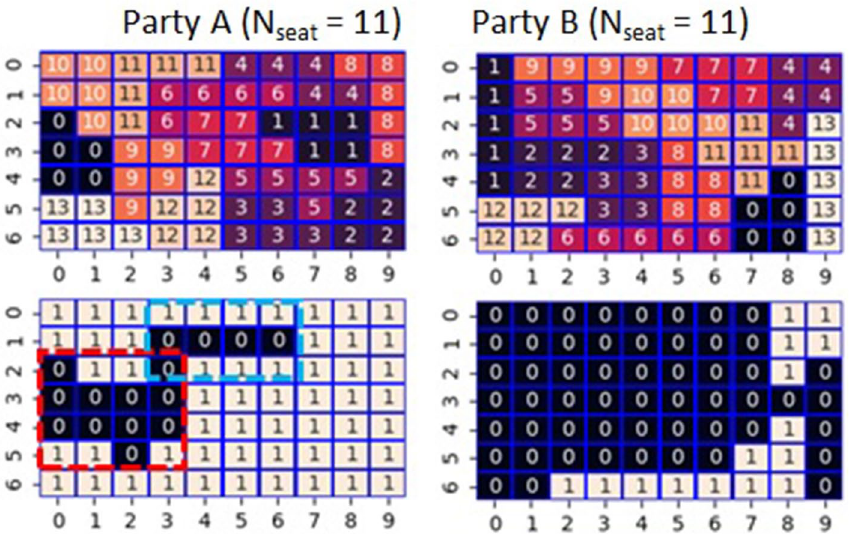
Figure 2. Calculated result of maximizing the number of seats so that party A or B has an advantage with imposing the rook constraint concerning the supporter’s distribution shown in Fig. 1 (Case 1). The top panels show the calculated correspondence between the cells and the 14 districts indexed from 0 to 13. The bottom panels show the assignment of seats based on the calculated